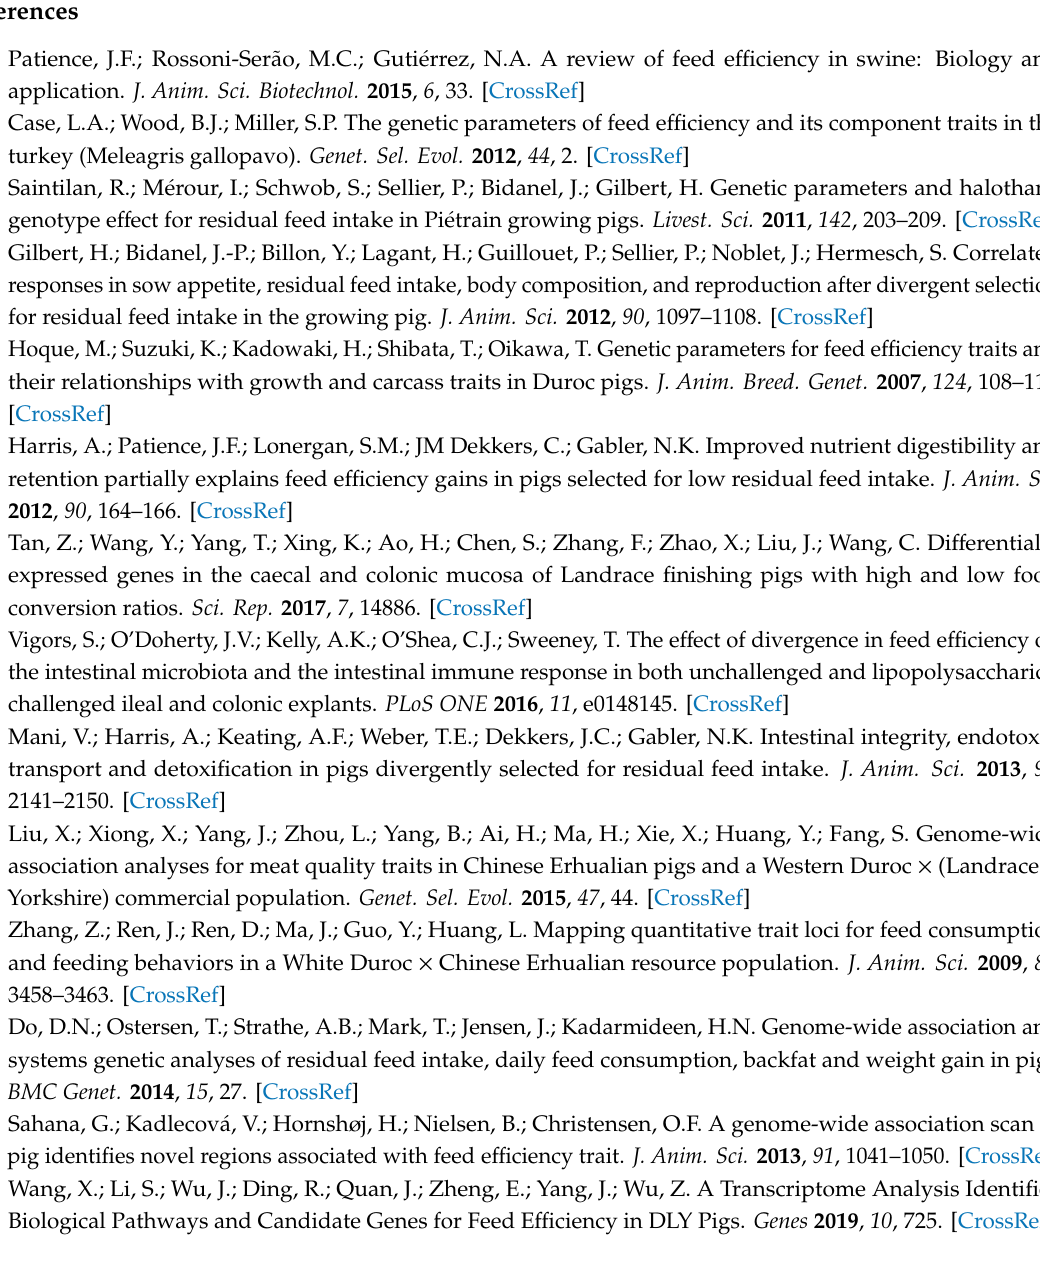
S5: Gene ontology enrichment result, Table S6: KEGG enrichment result and Table S7: ReactomePA pathway enrichment